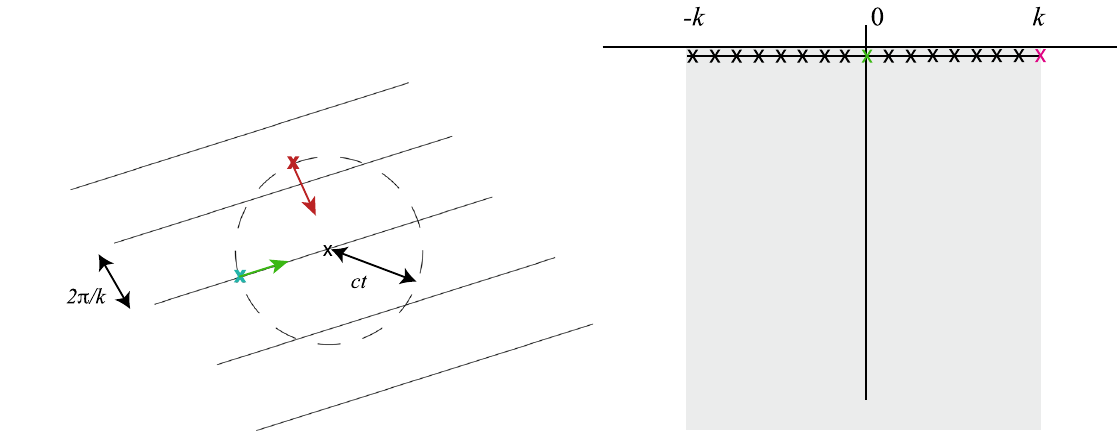
radius c t .Righthandside:Analyticstructure oftheretardedcorrelation αβ,γδ (ω, k ) in the complex frequency plane. The physics of functions G R free streaming particles is reflected in a branch cut along the real